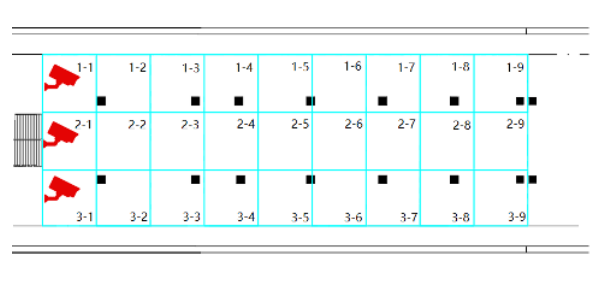
Fig. 1. The scheme of cameras and sub-aeras of subway station